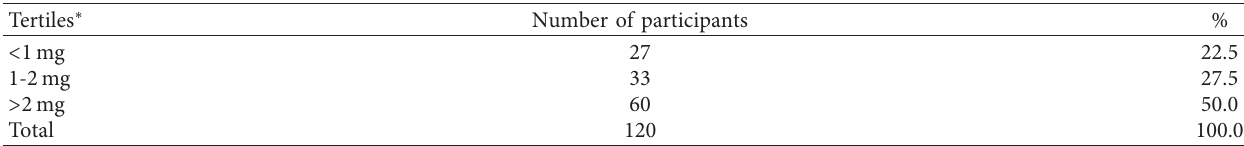
Table 4: Number of participants in each tertile based on consumption of dietary L / Z .